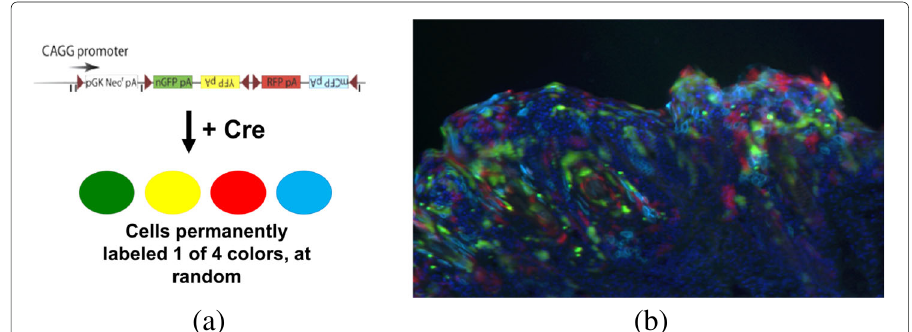
Fig. 1 Preparation of ‘Confetti’ Mice. a The “confetti mouse” is an engineered mouse strain carrying the Confetti cassette comprising short cDNA sequences that encode 4 different fluorescent proteins, separated by “LoxP” sites that enable cutting by the enzyme Cre-recombinase. The cassette is inserted into the ROSA locus under the control if the strong CAGG promoter. Activation of Cre-recombinase with Tamoxifen results in cutting of the DNA at the LoxP sites in a random manner, resulting in labelling of each cell with one of the 4 colors shown. b Fluorescent image of a benign papilloma one week after activation of the Cre-recombinase, showing labelling of each cell with one of the 4 colors. Confetti mice were initially treated using a standard protocol for inducing the growth of squamous tumors which results in the development of benign papillomas on the skin after about 10-15 weeks. At this stage the mice are treated with Tamoxifen, resulting in activation of a single fluorescent color in each individual cell. This picture was taken 1 week later, at which point some of the individual cells had already divided, giving rise to small clusters of cells with the same color